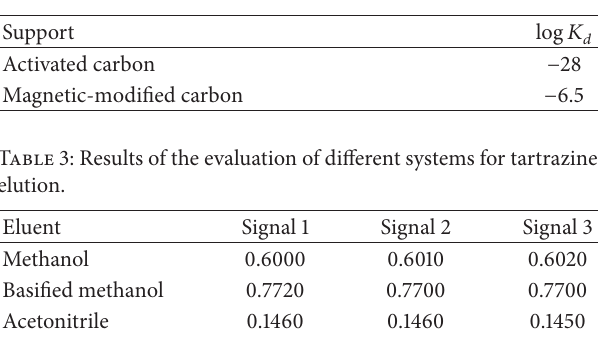
Figure 4: Adsorption isotherms for tartrazine on magnetic carbon modified at pH values ( ∙ ) 5.0, ( 󳵳 ) 7.0, and ( ◻ ) 9.0. Table 2: Tartrazine magnetic-modified carbon support dissociation constants.